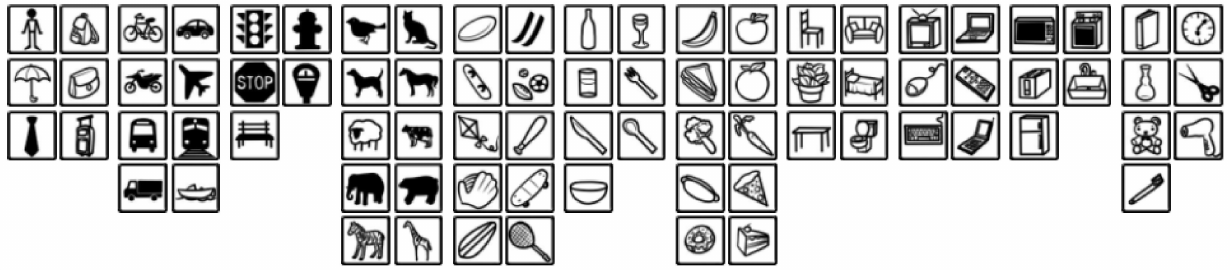
Figure 14. The 80 object categories in the COCO dataset. Adapted from ref. [48].